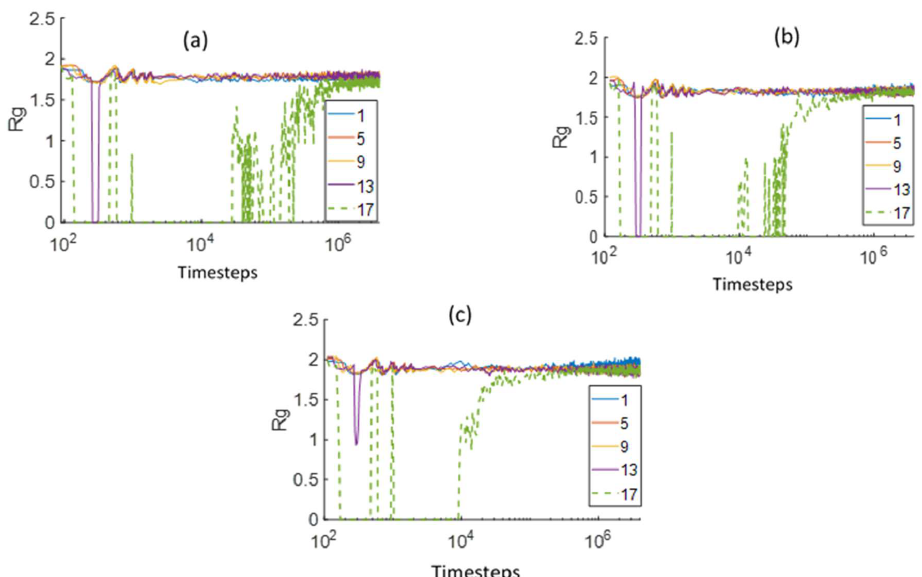
Figure 7. Comparison of the chain radius of gyration ( R g ) in different layers (1–17), at varying distances from the bottom Z boundary, for ( a ) Dow, ( b ) Nafion, and ( c ) Aciplex PEMs. Layer 1 is nearest to the bottom Z-boundary and layer 17 is at the interface of water and the membrane. Each layer is 2.25 DPD units thick. The green dashed line is the Rg value in a layer near the water–PEM interface.